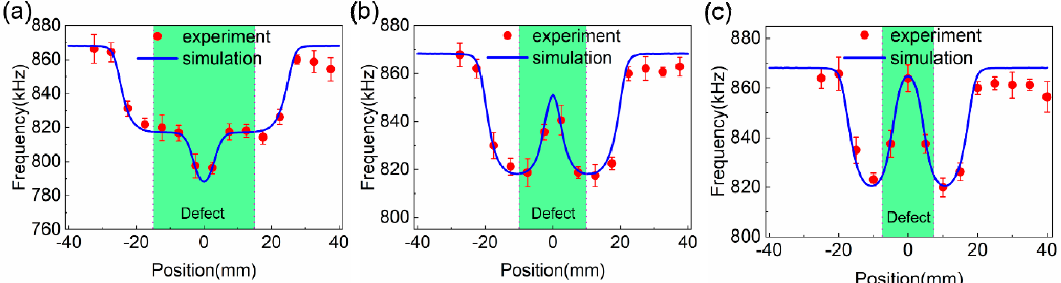
Figure 5. Comparison of experiment and simulation resonant frequency results of non-destructive scanning using a large size defect (30 mm × 15 mm × 3 mm) ( a ), a middle size defect (20 mm × 15 mm × 3 mm) ( b ), and a small size defect (15 mm × 15 mm × 3 mm) ( c ), and the green area indicates where the defects located.